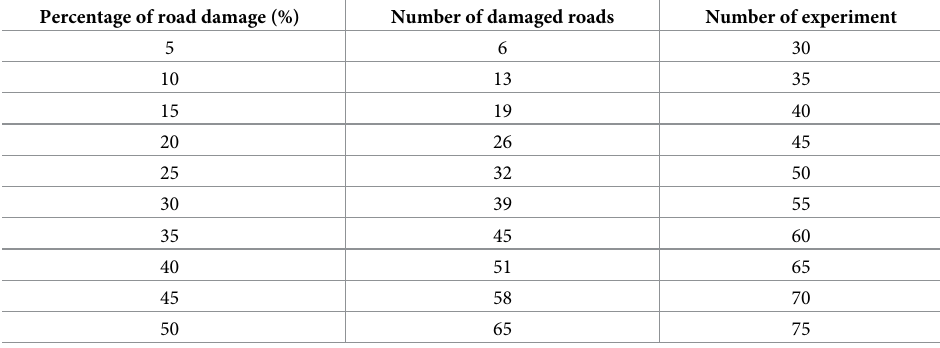
Table 6. Simulation tests of distribution cost of 65–38. Percentage of road damage